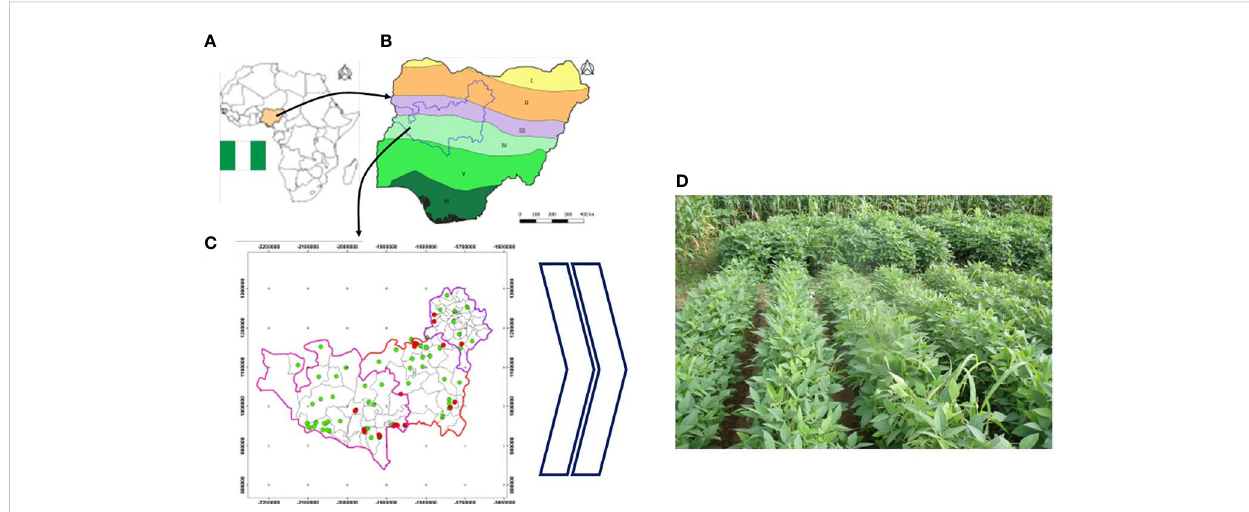
FIGURE 1 Map of Africa (A) and the different agroecological zones in Nigeria (B) , on-farm demonstrations areas (C) , and different fi eld operations (D) fi eld Rhizobia + P fertilizer combination and non-inoculated